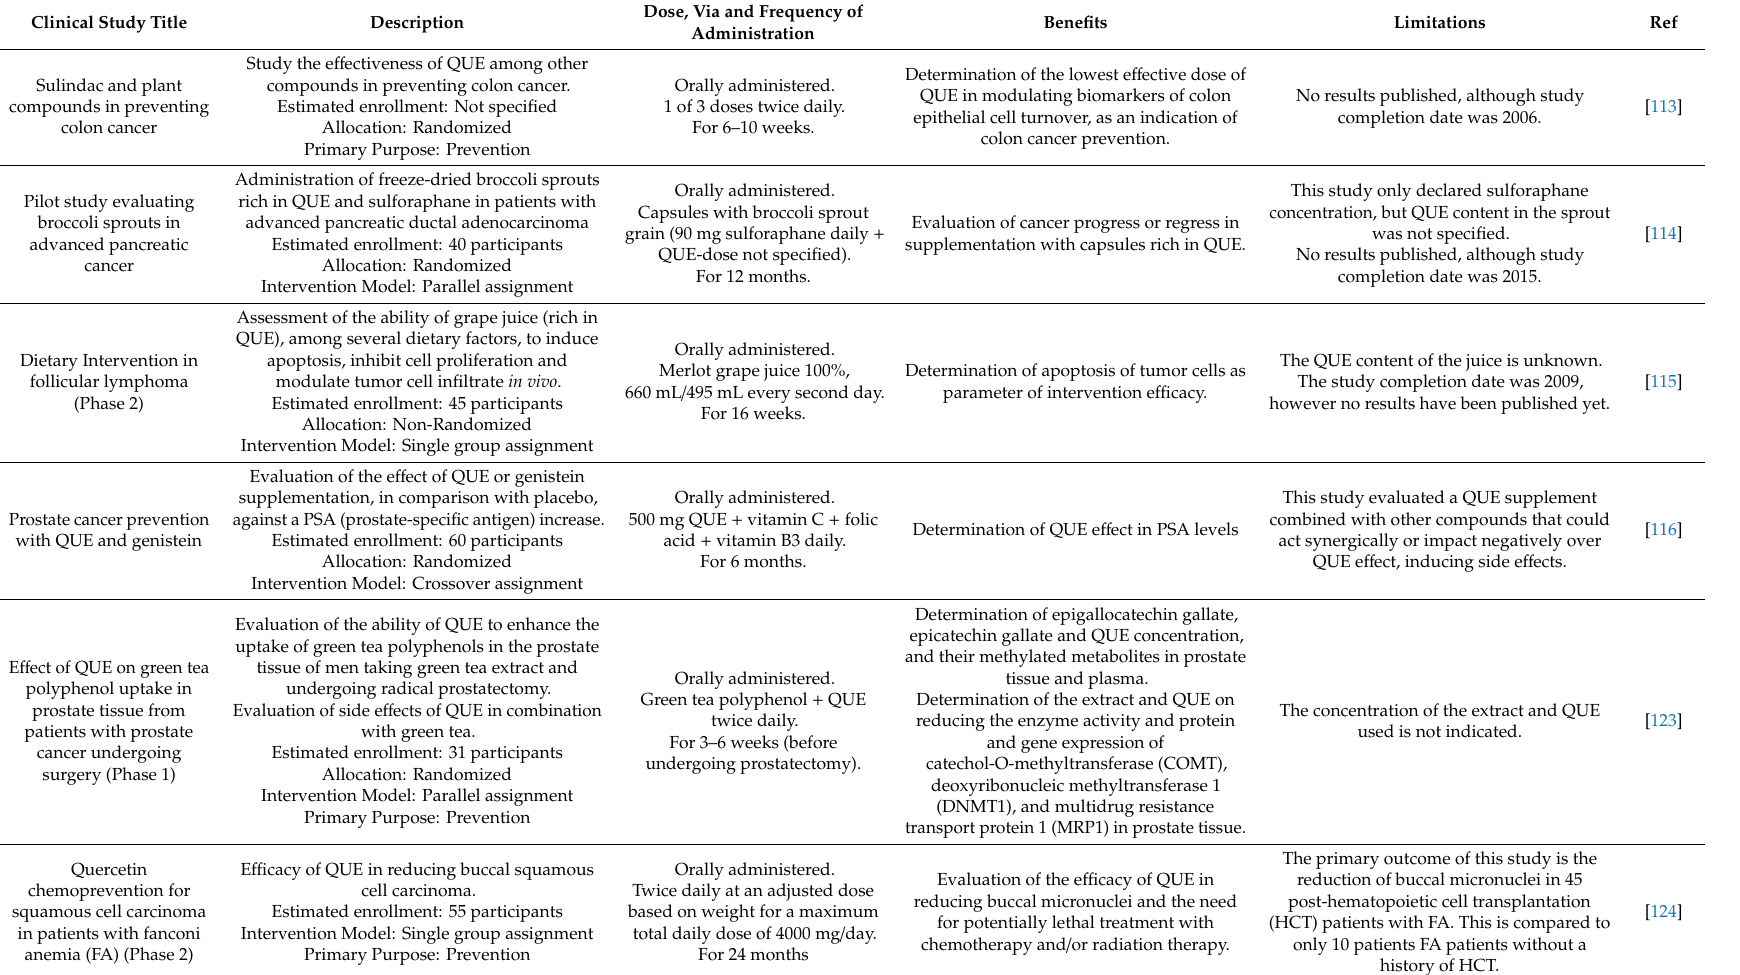
Table 2. Clinical trials evaluating the anti-cancer e ff ect of